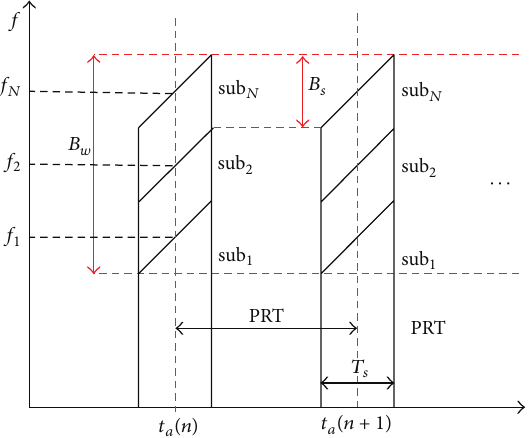
Figure 2: Relationship of time frequency of transmitted